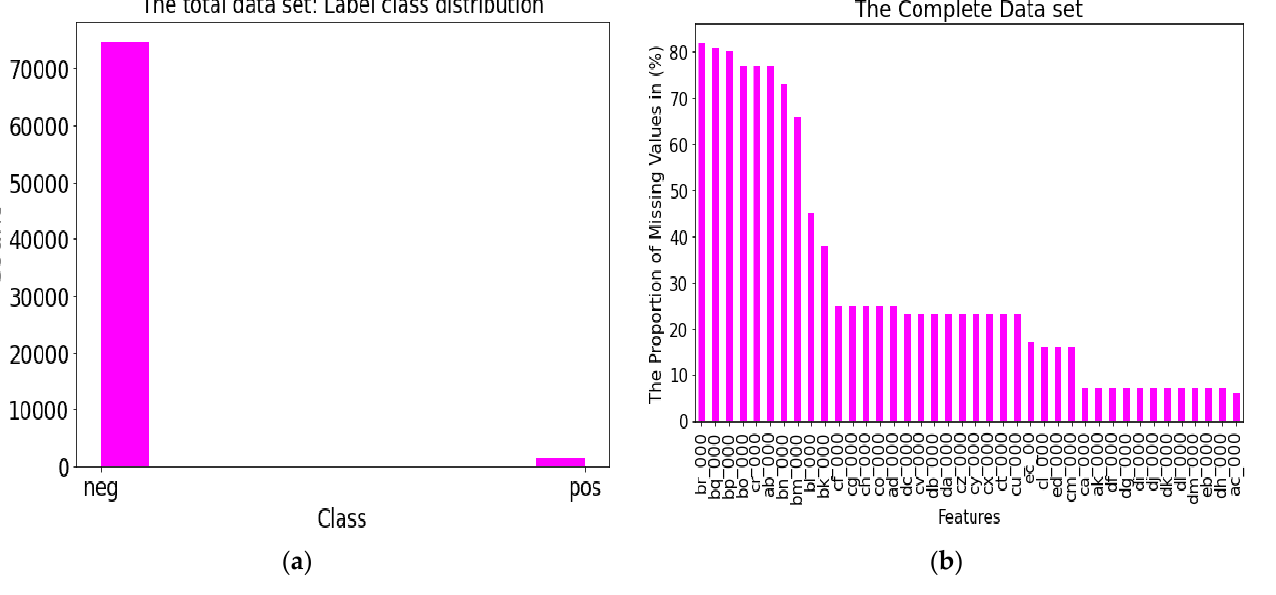
Figure 1. The distribution of the data set: ( a ) shows the class distribution and the imbalance of class distribution for the complete data set; ( b ) shows the percentage of missing values in each feature of the data set.